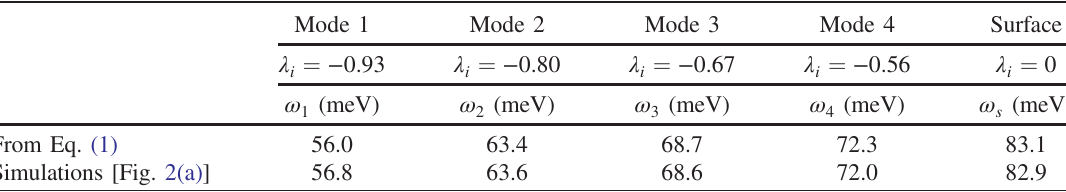
TABLE I. Comparison between energy values for the nanoantenna in Fig. 1(d) calculated with Eq. (1) and as extracted from the simulated spectra in Fig. 2. Inputs for Eq. (1) are ω [22]. Simulations have been performed in the full retarded approximation, with the experimental dielectric constant found in Ref. [22].